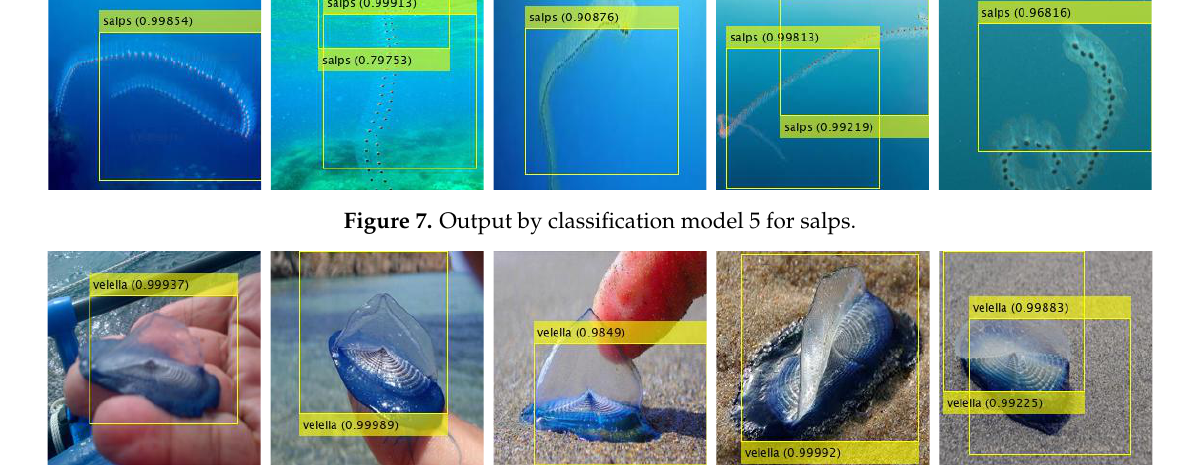
Figure 8. Sample of images that show Velella velella individuals which were used for